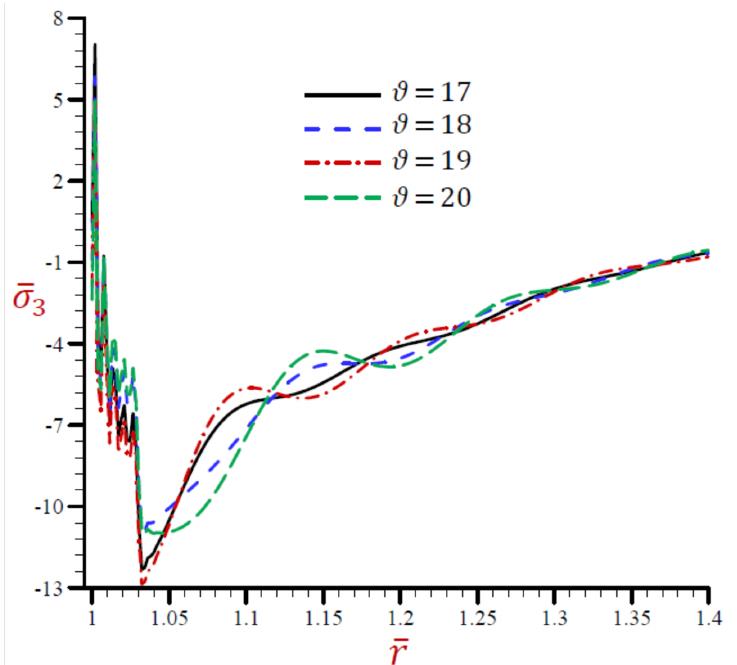
Figure 18. Effect of ϑ on radial stress σ 3 across the radial direction of the cylindrical cavity utilizing the RDPL model.